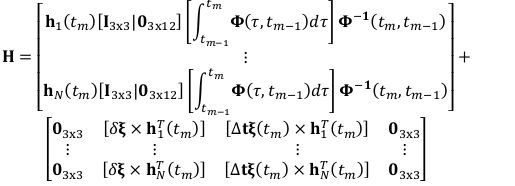
Figure 7. Integration strategy when GPS is available.